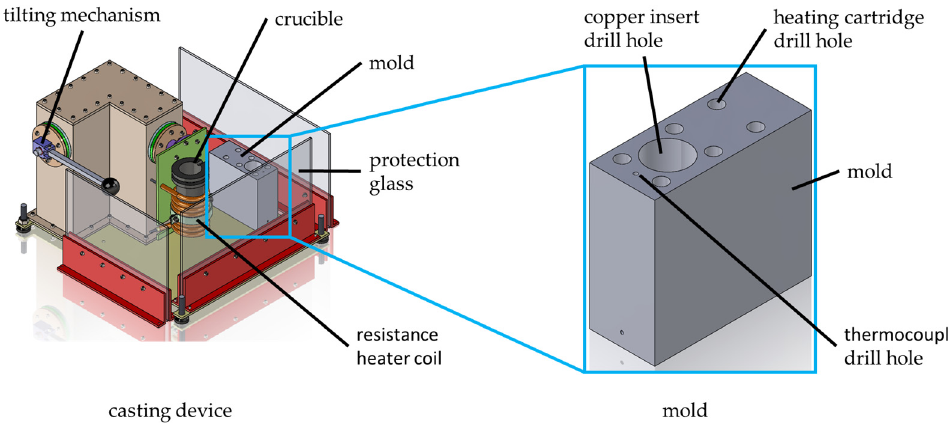
Figure 1. Schematic of the oxygen-free glovebox and the casting device including the mold.